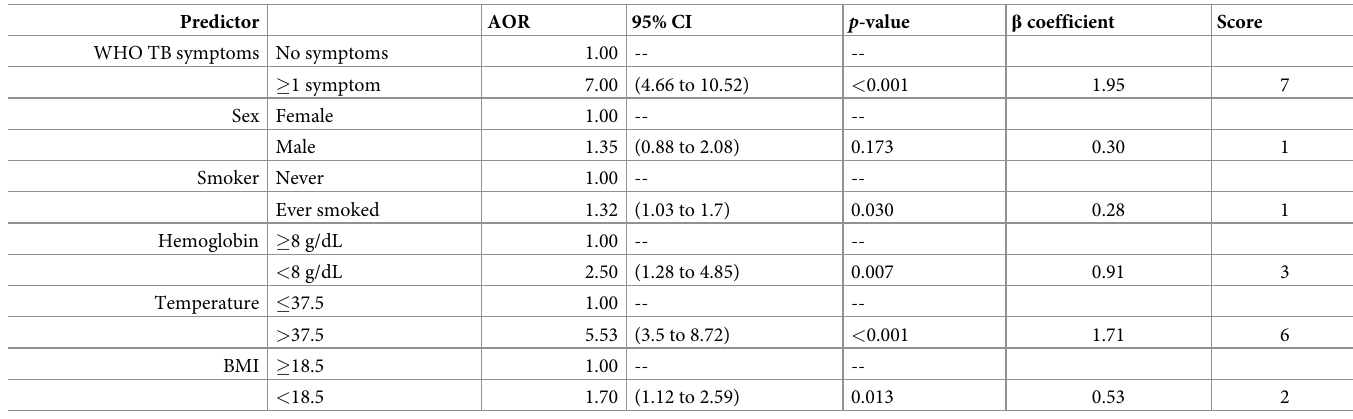
Table 3. Multivariable model and clinical score in the derivation dataset ( N = 2,771). Predictor AOR p -value β coefficient Score WHO TB symptoms No